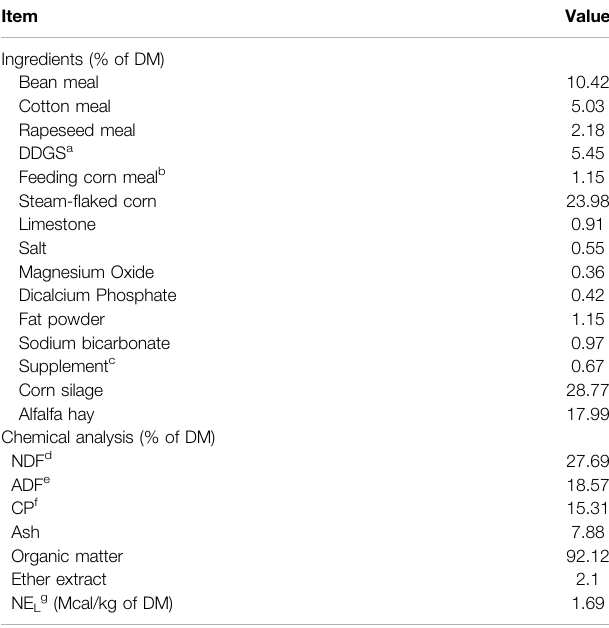
TABLE 1 | Ingredients and nutrients of experimental diet (DM